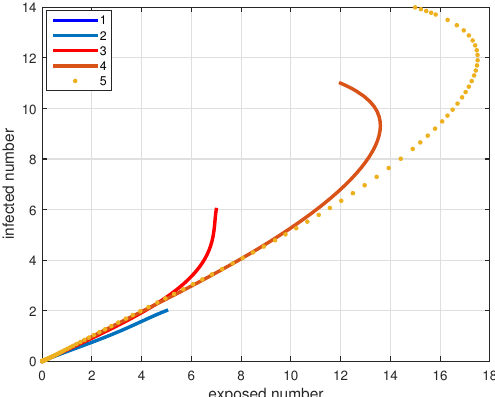
Figure 5. The phase portraits of I vs. E for system (1). The five trajectories correspond to different initial conditions and R 0 = 0.1087 < 1.